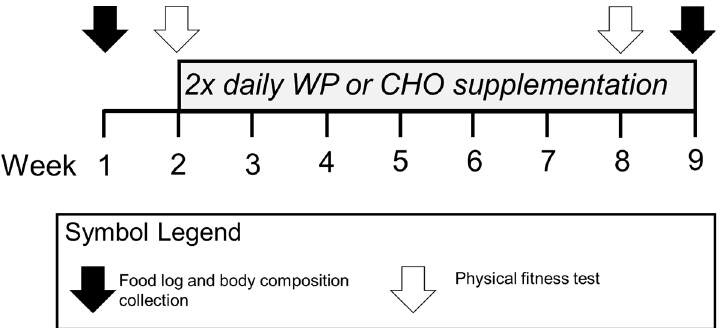
Figure 1. Summary of measures collected during Initial Entry Training (IET). This figure illustrates the logistics of the 8-week supplement intervention. logistics of the 8-week supplement